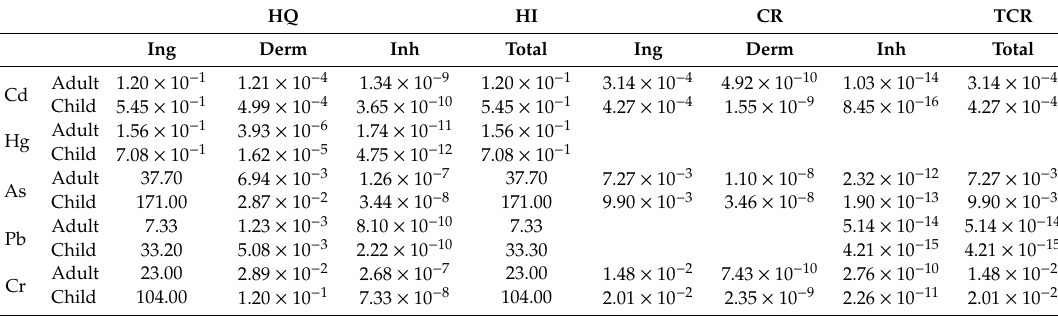
Table 4. The potential hazard risk (HI) and total risk (TCR) of five PTEs for people exposed through di ff erent routes.